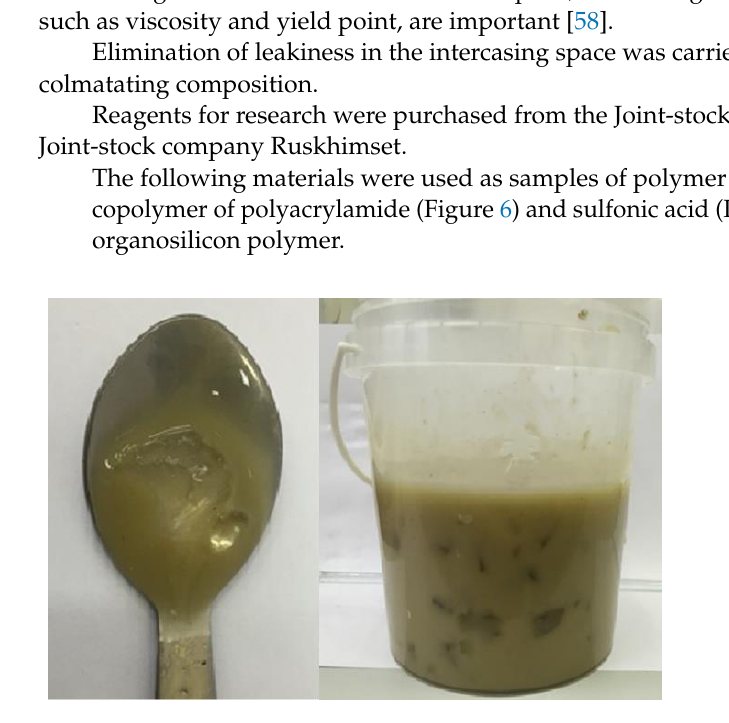
Figure 6. Aqueous polymer solution of polyacrilamide.